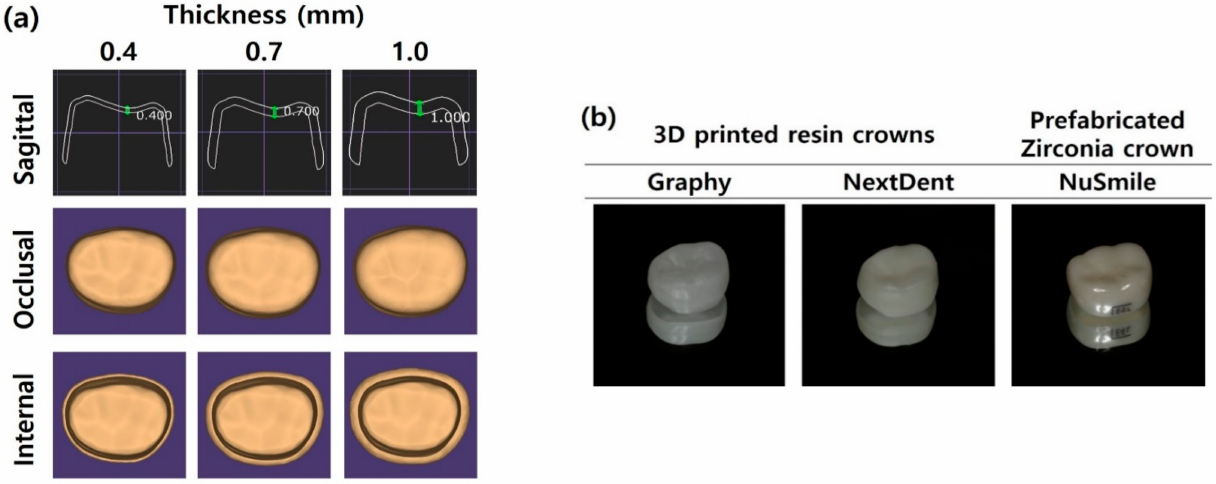
Figure 1. The shape of the crowns used in this study: ( a ) CAD/CAM designs of 3D printed resin crowns